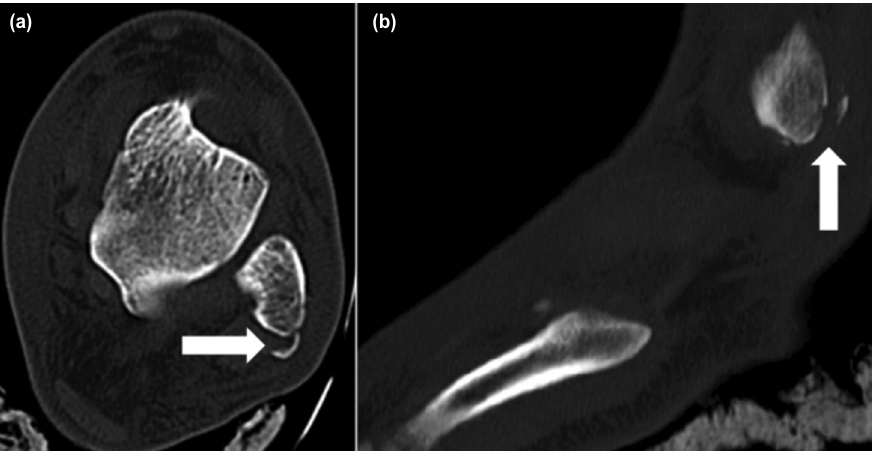
(a) Axial and (b) Sagittal CT scan show avulsion of superior peroneal retinaculum from the fibula. Fig. 2: